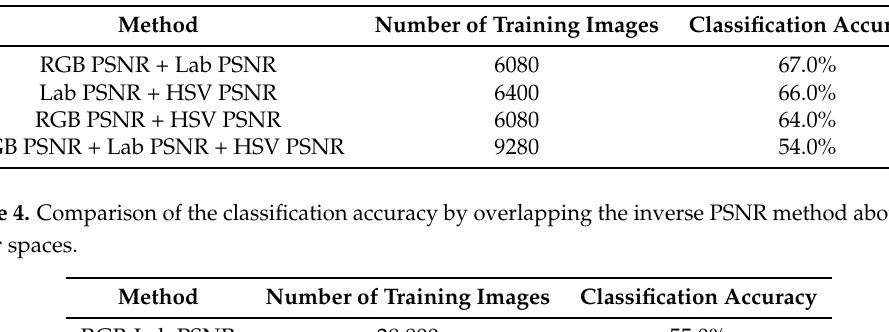
Table 3. Comparison of the classification accuracy by joining the PSNR results.